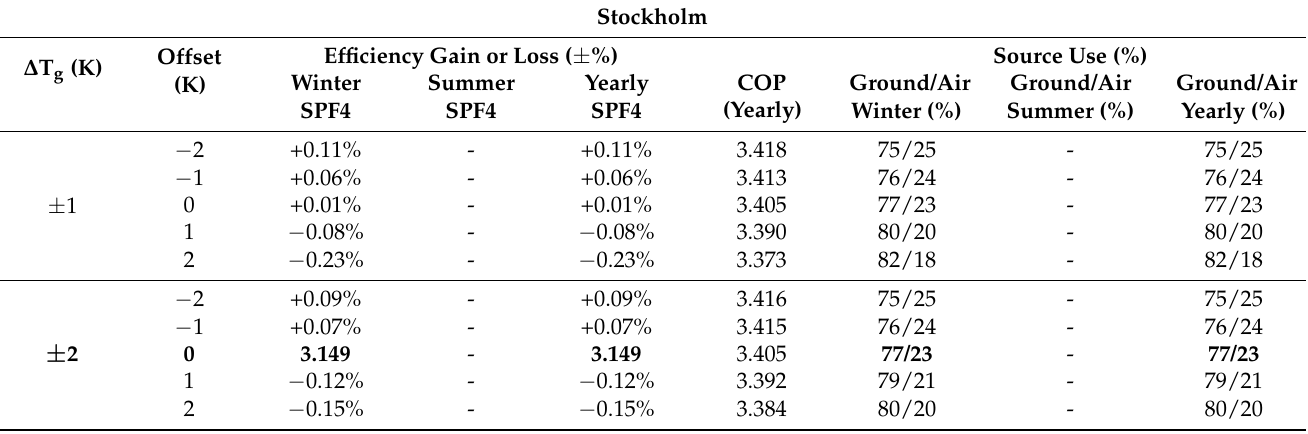
Table 14. Efficiency gains and the rate of ground/air use for both seasons in Stockholm, Strasbourg, and Athens. The reference corresponds to an offset of 0 K (in